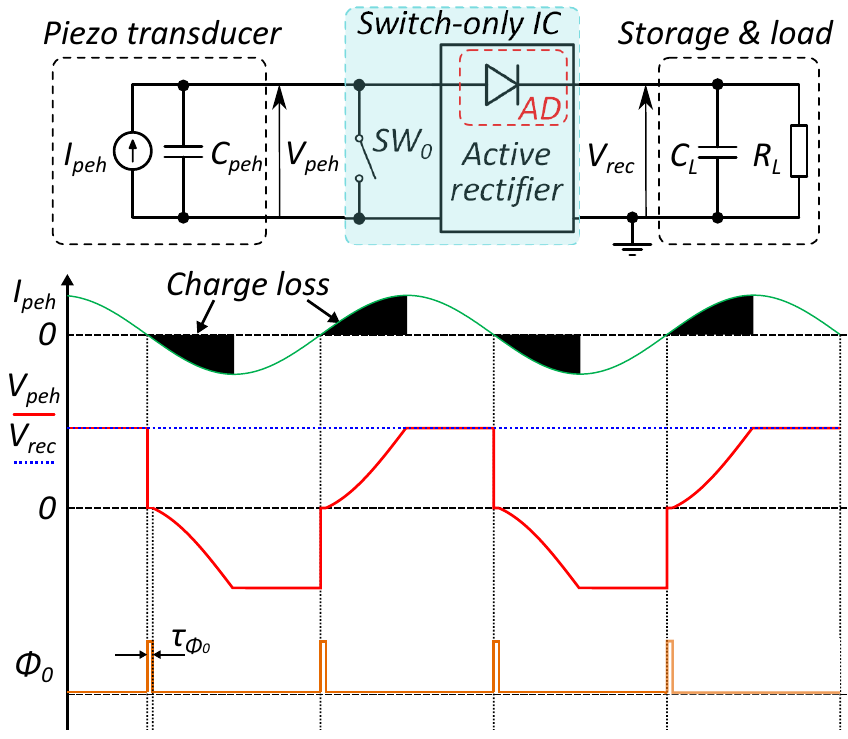
Figure 5. Switch-only architecture and related signal when V rec is regulated to ˆ V OC .